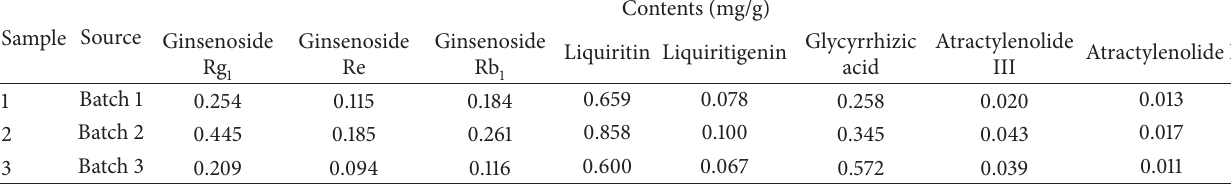
Table 4: Contents of eight components in three batches of